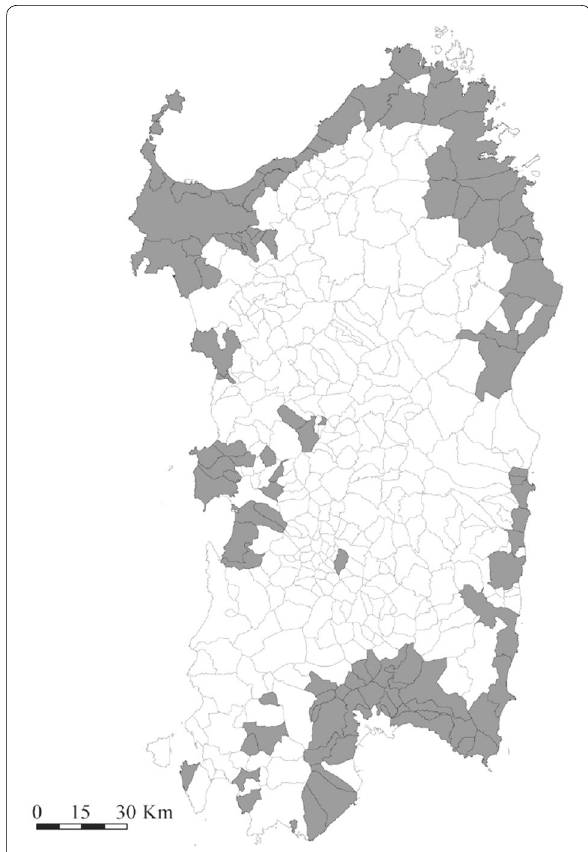
Fig. 2 Map of municipalities (in grey) with an increase of population in the period 1991–2016. The others have a decrease of population (Source: Elaboration from Istat data)